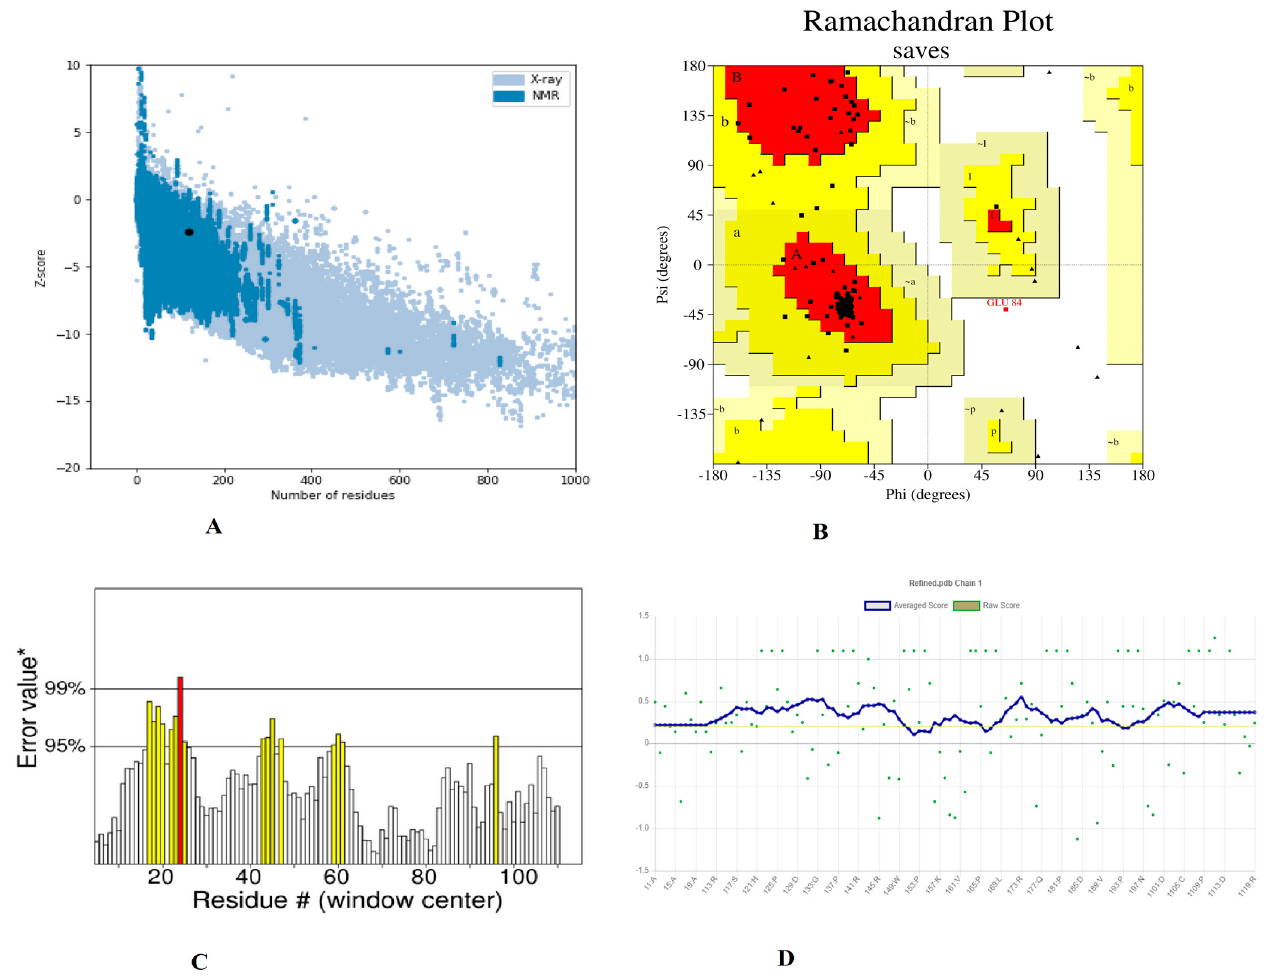
Figure 4. Validation of the 3D structure model of refined vaccine construct ( A ). Z-core of construct model calculated − 2.37 which in range of conformation scores of native protein ( B ). Ramachandran plot validation indicates; 88%, residues are in favored, 10.7% residues in allowed and 1.3% residues in disallowed region ( C ). ERRAT factor of final construct structure was 84.90%. In ERRAT plot, gray lines are showing regions of 3D model that can be rejected at 95% confidence level and yellow lines depicting regions that can be rejected at 99% level ( D ). The 3D score of the final model was 92.44% and amino acid residues with an average 3-1D score greater than zero are regarded as reliable.